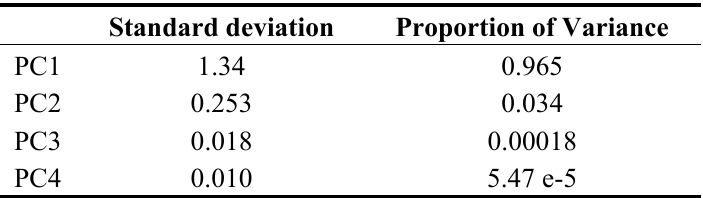
Table 2. Importance of the first four